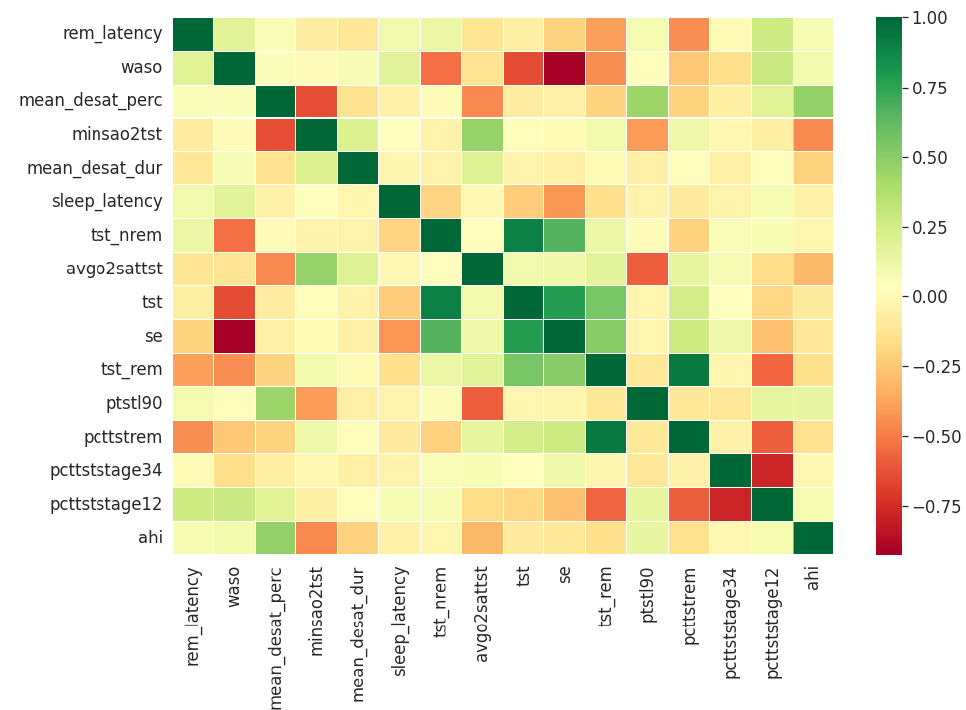
Figure 6. PSG features ordered as per Pearson’s Correlation